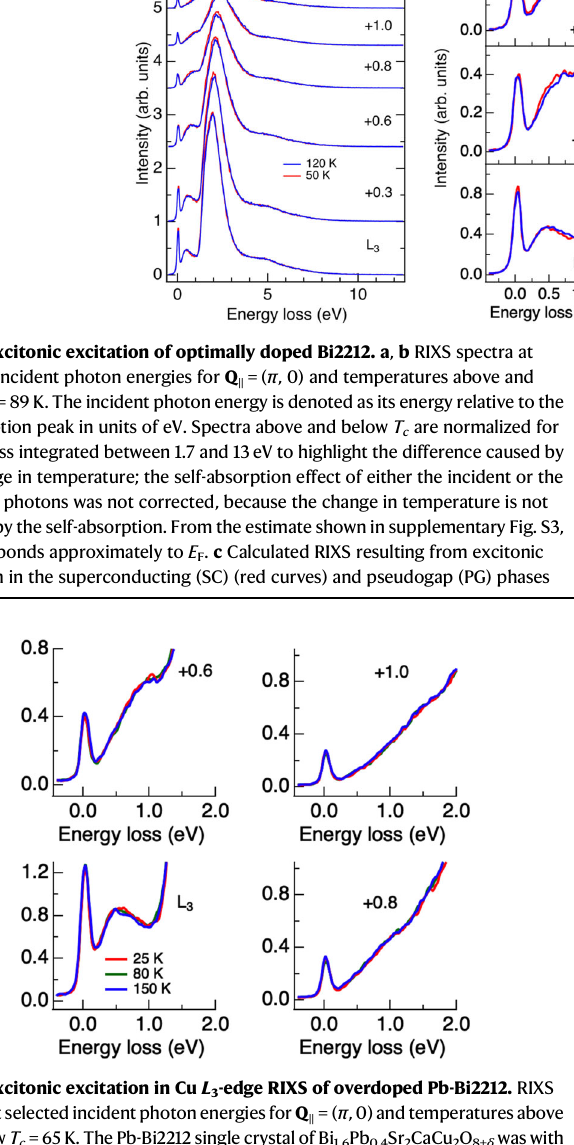
Fig. 3 | Excitonic excitation in Cu L 3 -edge RIXS of overdoped Pb-Bi2212. RIXS spectraatselectedincidentphotonenergiesfor Q ∥ =( π ,0)andtemperaturesabove andbelow T c =65K.ThePb-Bi2212singlecrystalofBi 1.6 Pb 0.4 Sr 2 CaCu 2 O 8+ δ waswith aholedopinglevelof p =0.22±0.005.Theincidentphotonenergyisdenotedasits energy relative to the L 3 absorption in units of eV. Spectra above and below T c are normalized for energy loss from 2 to 13eV. The self-absorption effect of either the incidentorthe scattered photonswasnotcorrected.SeeFig.S7forfull-rangeRIXS spectra.